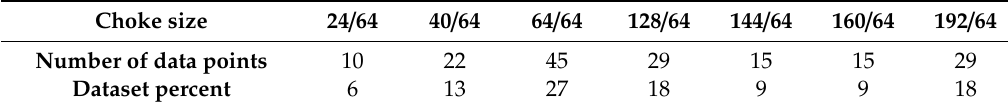
Table 4. Individual choke sizes and number of corresponding data points.